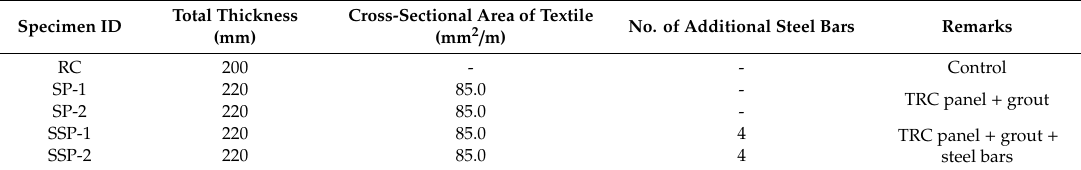
Table 3. Characteristic of full-scale slab specimens.